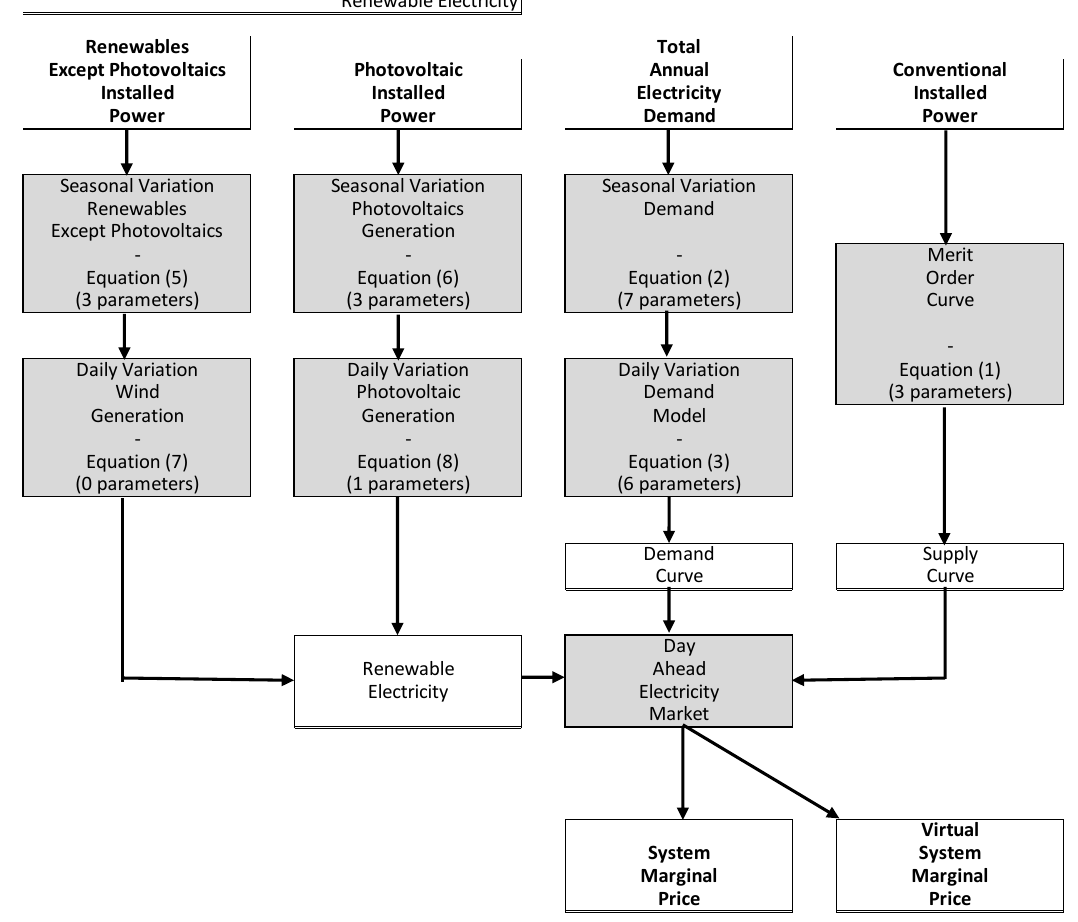
Figure 2. Model information flow diagram.